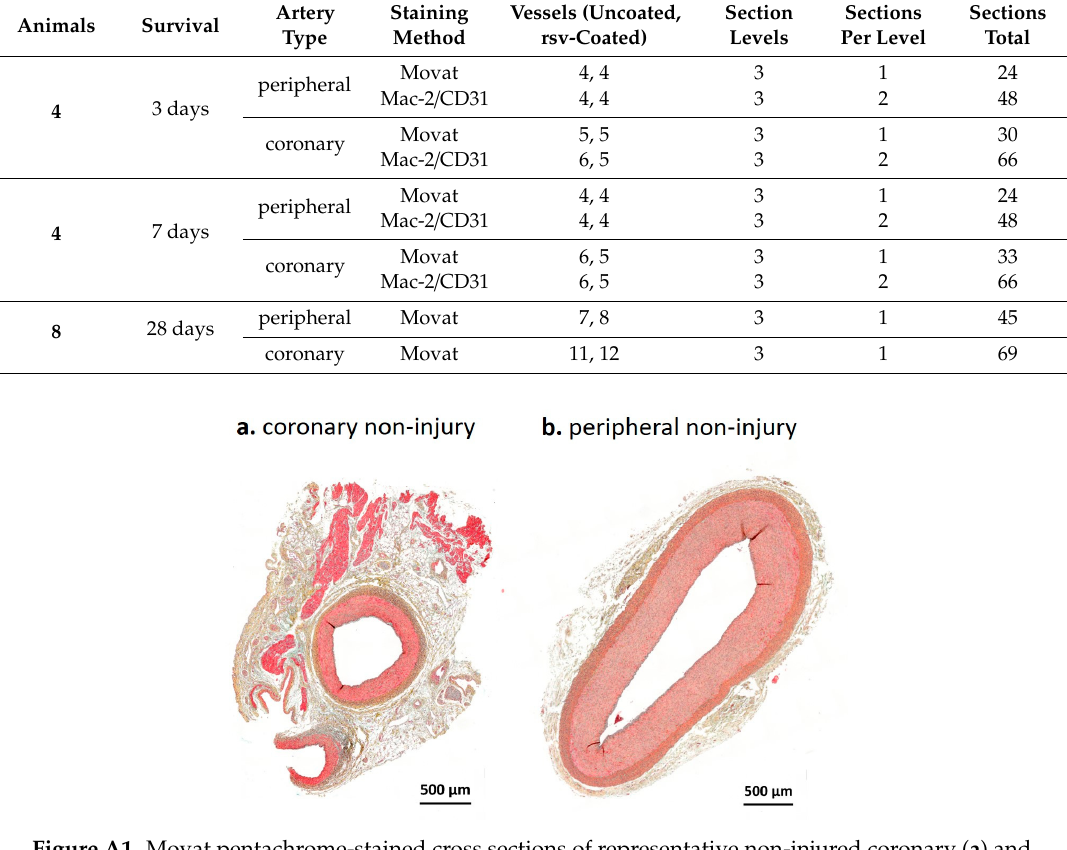
Figure A1. Movat pentachrome-stained cross sections of representative non-injured coronary ( a ) and peripheral ( b ) arteries.